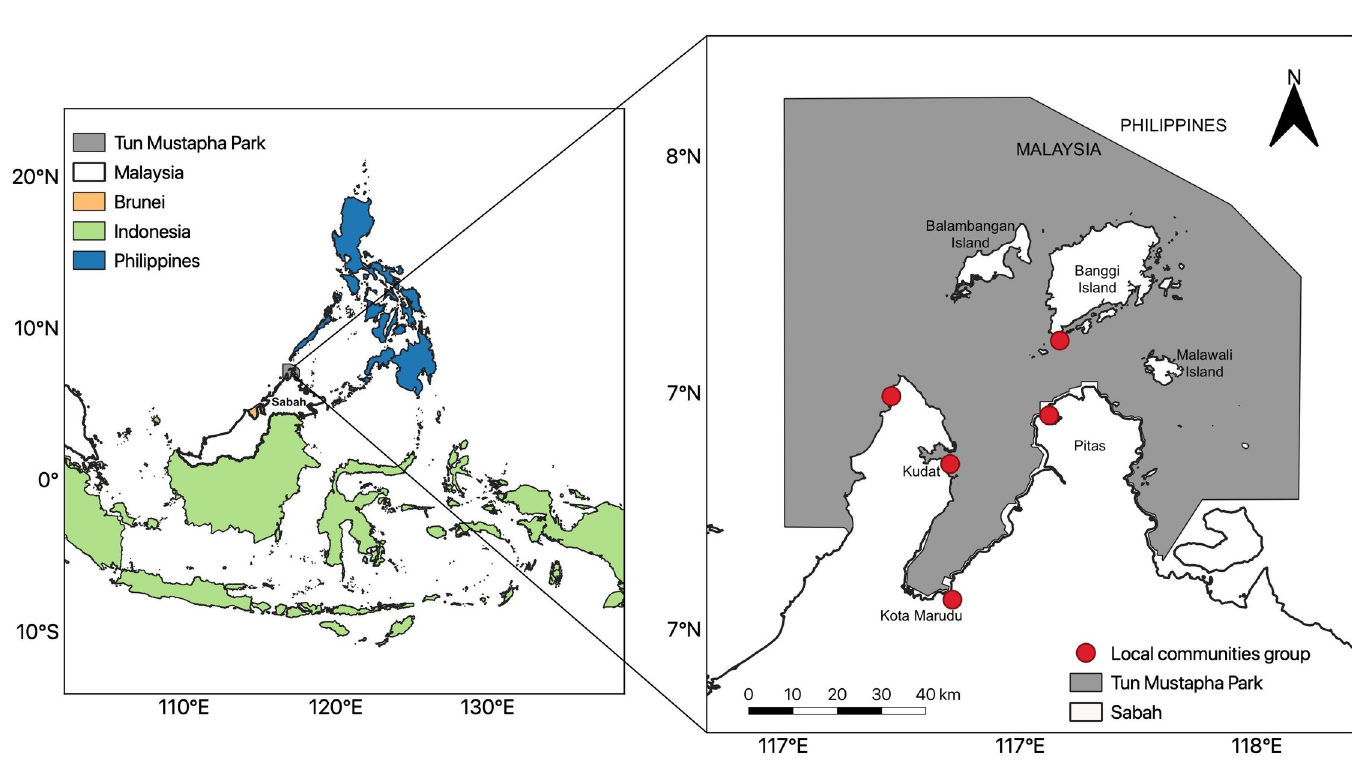
Fig 1. The study site which is Tun Mustapha Park. This study site is located along the international boundary between Malaysia and Philippines. Participants for this project were recruited from five community groups residing in the marine park. The spatial data was created using QGIS 3.3.3 based on the public dataset by Natural